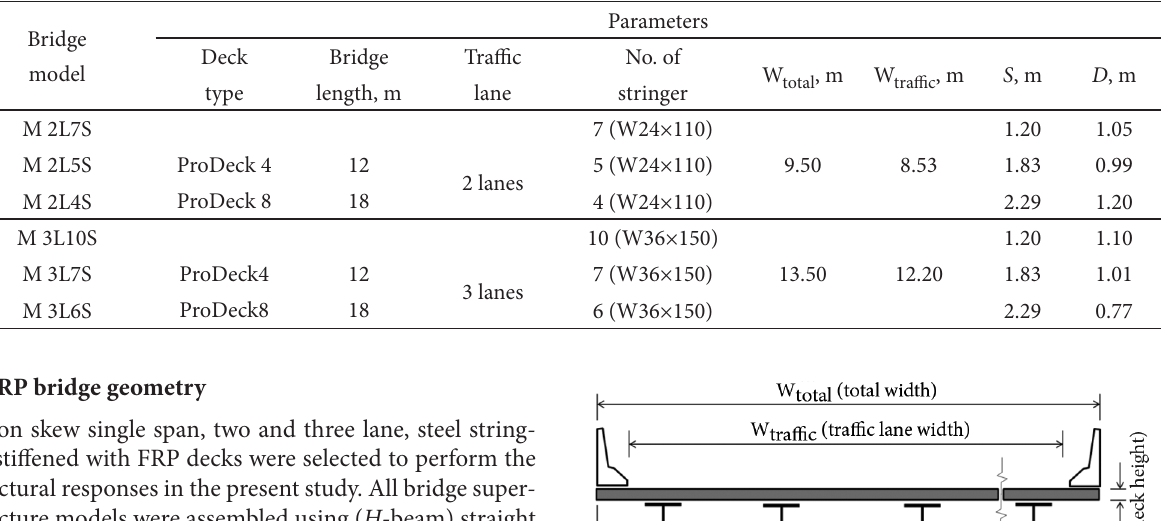
Table 2. Bridge model